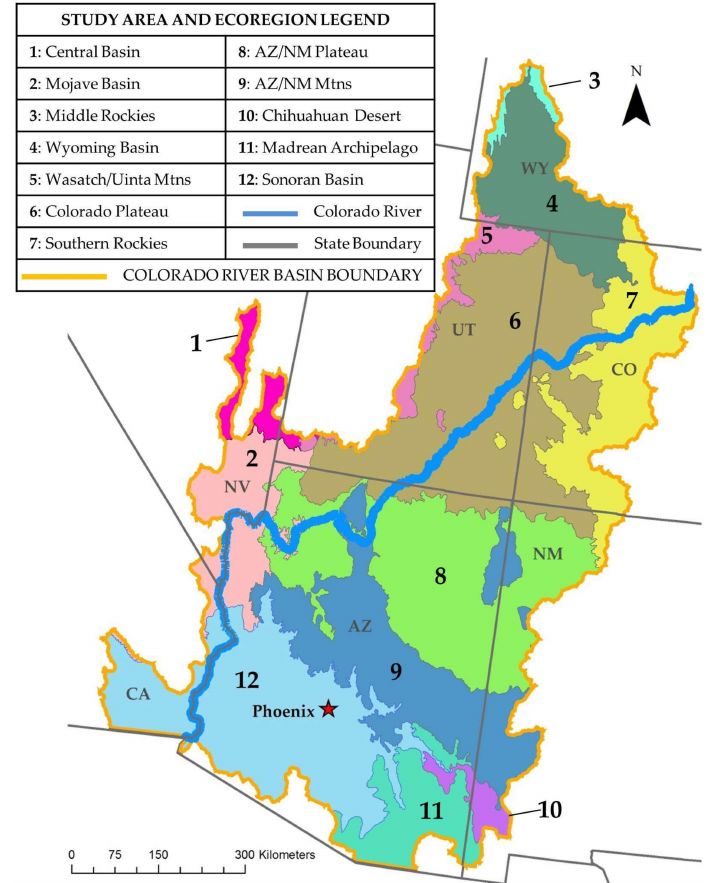
Figure 1. The study area extent, which encompasses the entire US portion of the Colorado River Basin, classified by EPA Level 3